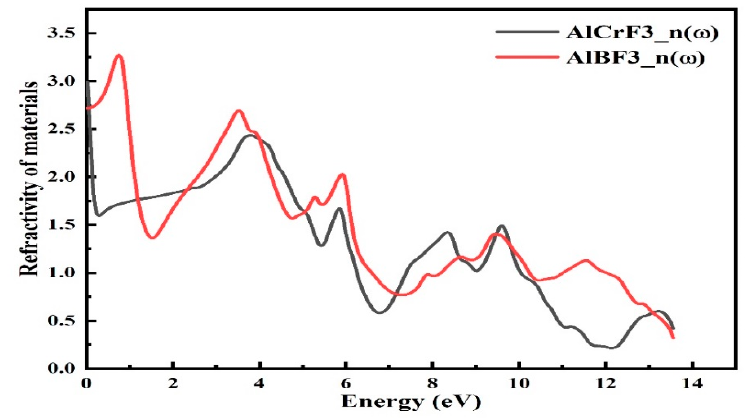
Figure 6. Figure represents the Refractive Index n(w) for the AlMF 3 (M= Cr, B) compounds.